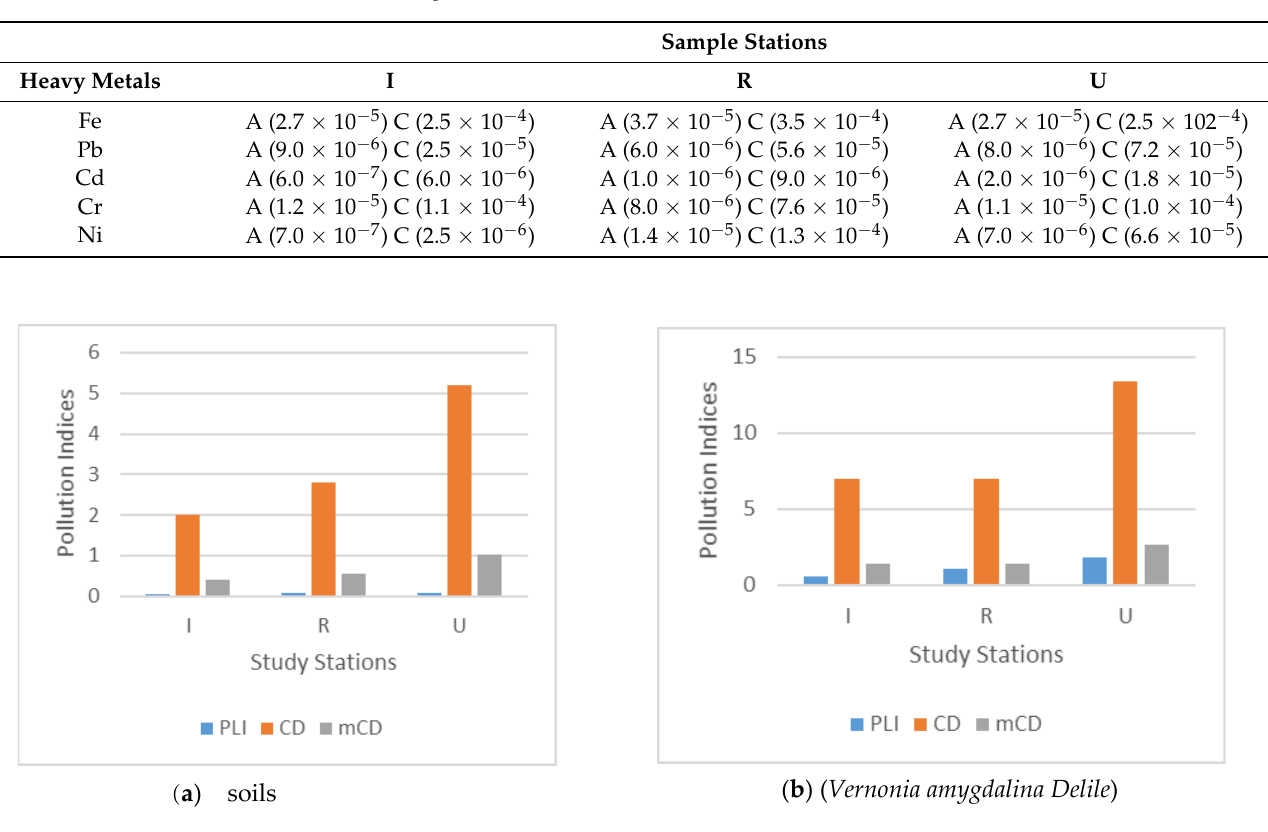
Table 4. CDI ing for the Soils in both adults (A) and children (C).